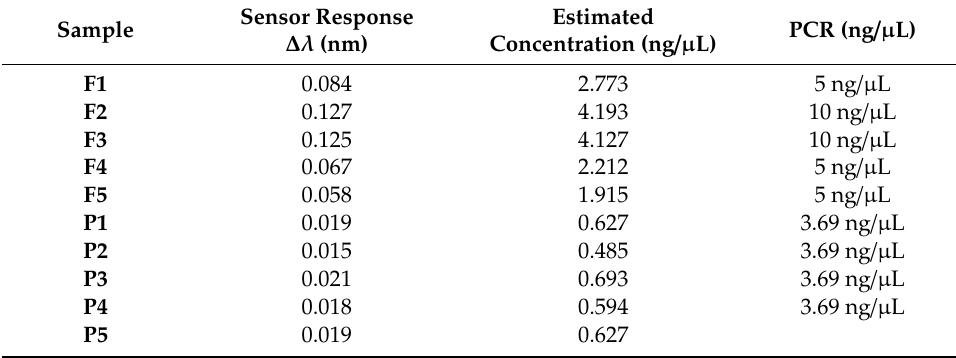
Table A3. Sensor response for synthetic pGEM-T Easy plasmids (P) and other fragments (F) that contained the mtLSU rRNA sequence. Estimated concentrations evaluated with the SPR biosensor and comparison with PCR